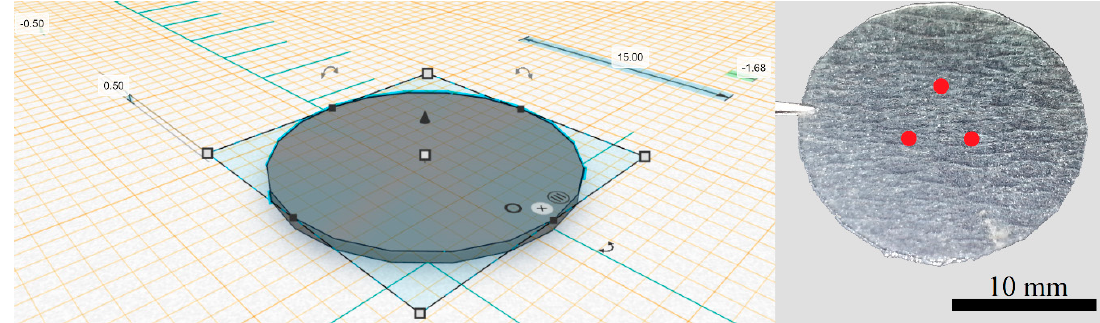
Figure 1. TinkerCad desing of the 3D printed nail ( left ) and image of 3D printed nail printout: red dots signify the approximate locations that were scanned using confocal Raman spectroscopy ( right ).